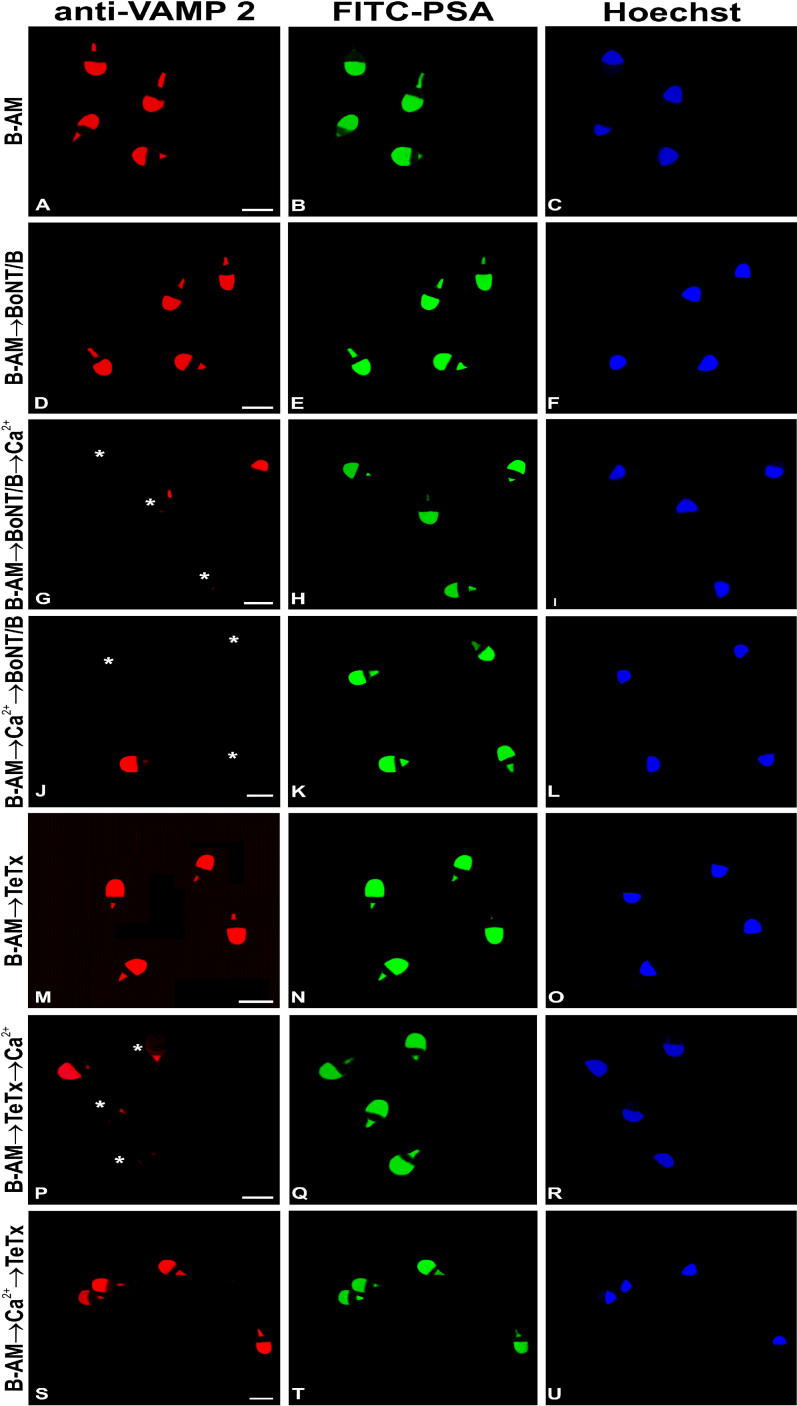
Effect of BoNT/B and TeTx on VAMP2 ImmunofluorescenceSperm were incubated with 100 nM BoNT/B or TeTx (15 min at 37 °C) as described in Figure 8. The cells were then triple-stained with an anti-VAMP2 antibody that recognizes an epitope that is cleaved by the toxin (red; [A, D, G, J, M, P, and S]), FITC-PSA to differentiate between reacted and intact sperm (green; [B, E, H, K, N, Q, and T]), and Hoechst 33258 to visualize all cells in the field (blue; [C, F, I, L, O, R, and U]). BoNT/B and TeTx had no effect on resting sperm (compare [D–F] and [M–O] with [A–C]). However, labeling in sperm stimulated with 10 μM Ca2+ in the presence of BAPTA-AM to prevent exocytosis (observe that the PSA staining is not affected) was significantly reduced by the toxins (asterisks, [G] and [P]). In contrast, when cells were first allowed to arrive at the intra-acrosomal Ca2+-sensitive step and then treated with toxins, BoNT/B caused a significant decrease of the VAMP2 label (asterisks, [J]), whereas TeTx had no effect (S). Bars = 5 μm.